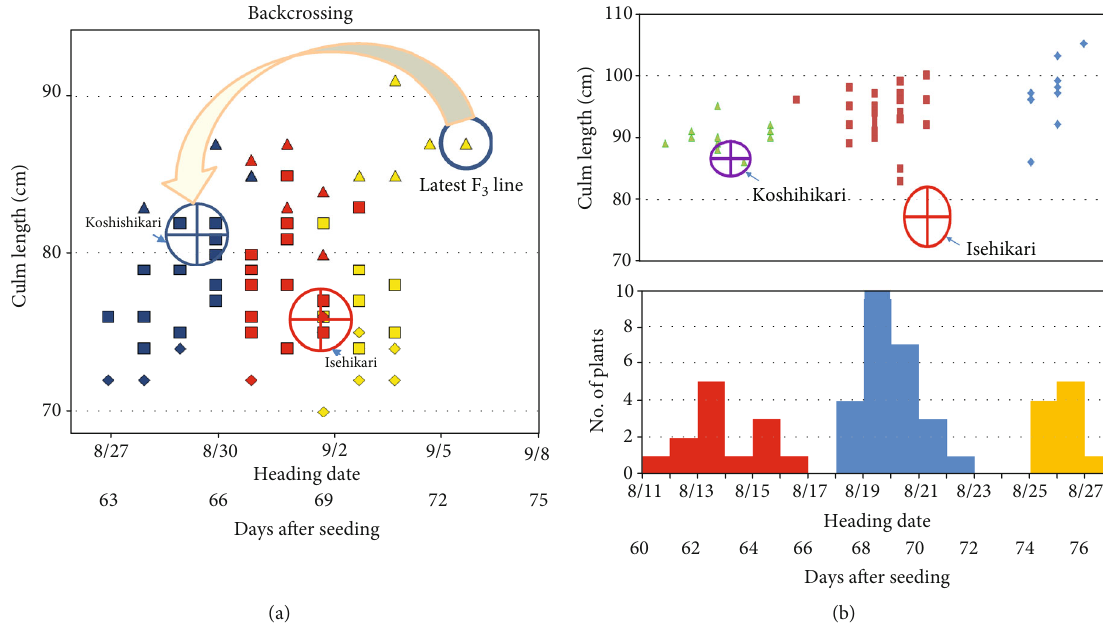
Figure 1: Genetic analysis for late maturity derived from Isehikari. (a) Distribution of mean value of heading date and culm length in 70 F 3 lines derived from the cross Koshihikari × Isehikari. Progeny tests were conducted on 70 randomly selected F plants by using self-propagated 2 70 F lines from each F plant. The genotype of the heading date was determined according to the ratio of 23 late-maturing homozygous 3 2 lines (tentatively Hd homo; blue): 26 heterozygous lines ( Hdhd ; red) :21 early maturing homozygous lines ( hd homo; yellow), which fi t to a theoretical single gene ratio of 1 :2:1 ( χ 2 = 4 : 74 , 0 : 05 < p < 0 : 10 ). The latest homozygous F line, which was 7 days later than 3 Isehikari, was backcrossed as a nonrecurrent parent with Koshihikari as a recurrent parent. (b) Frequency distribution of heading date in the BC F (Koshihikari × 3//(Koshihikari/Isehikari F ). In the BC F , early maturing plants heading like Koshihikari during 8/12 – 8/17, 3 2 2 3 2 midmaturing plants heading during 8/19 – 8/23, and late-maturing plants heading during 8/26 – 8/28 segregated in a ratio of 12 early maturations :28 midmaturations :10 late maturations, which was well consistent with a theoretical single gene ratio of 1 :2 :1 ( χ 2 = 0 : 88 , 0 : 50 < p < 0 : 70 ). The semidwarfness derived from Isehikari was segregated independently from late maturity in F and F (a). As the 2 3 latest homozygote without semidwarfness was used as a nonrecurrent parent, the late maturity was solely segregated in the backcross F 2 (b), and fi nally, a late-maturing isogenic Koshihikari was